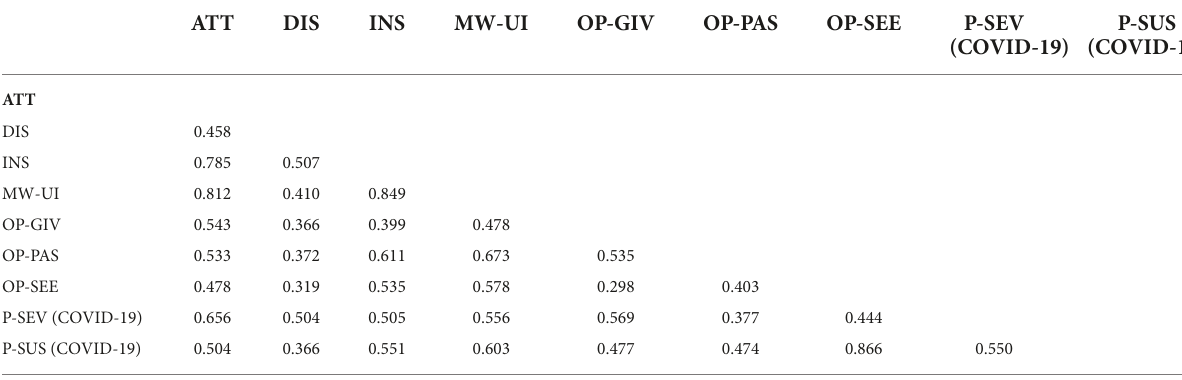
TABLE 4 Discriminant validity.